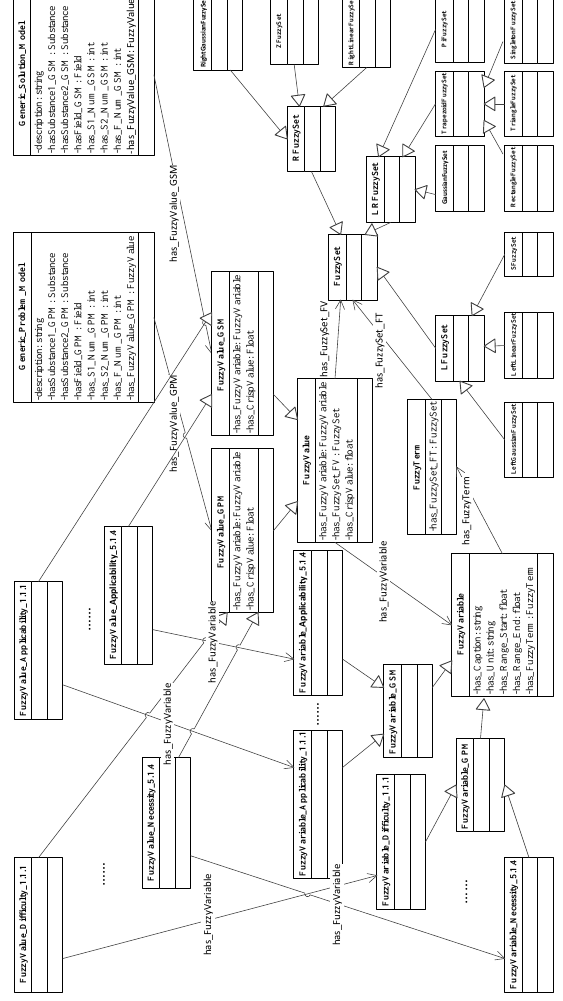
Figure 4. The framework of the fuzzy analysis